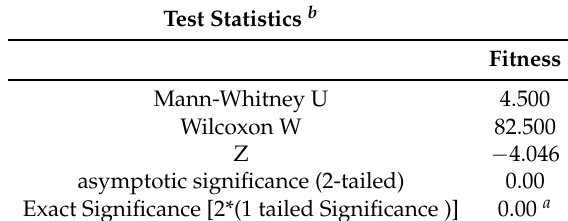
Table 5. Mann–Whitney U-test